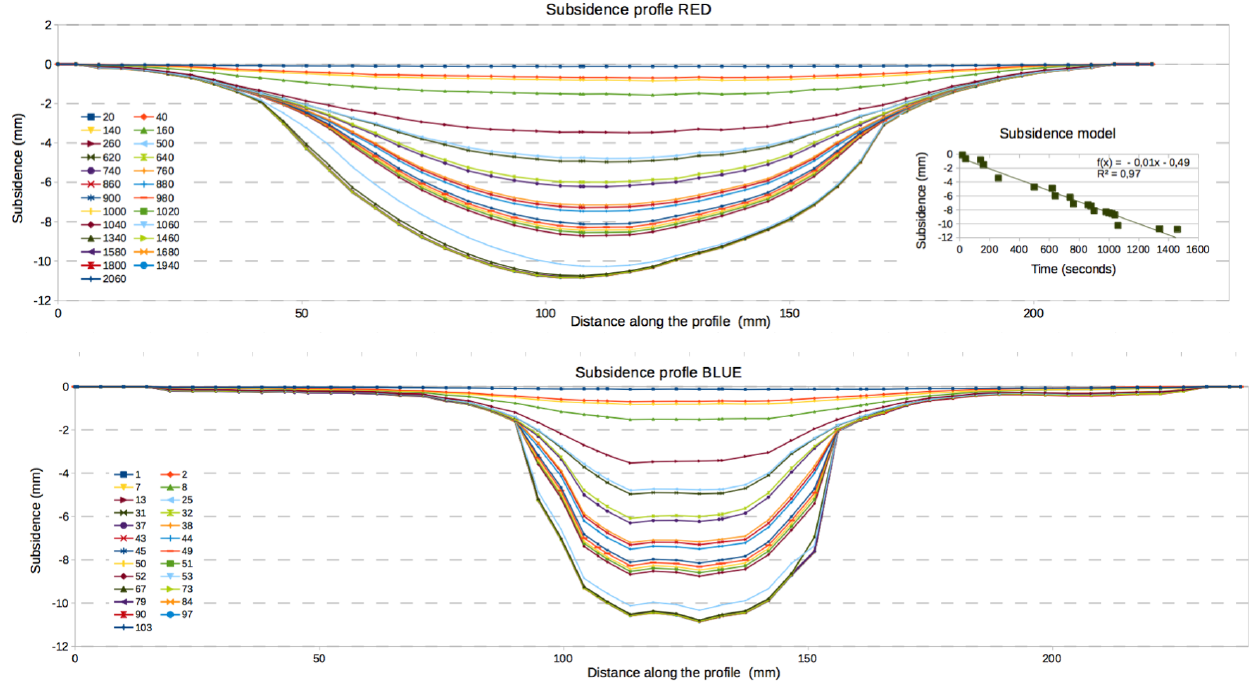
Figure 5. Topographic profiles obtained in the model in the direction: (a) parallel to the basement faults (RED) and, (b) the profile orthogonal to the parallel faults (BLUE).